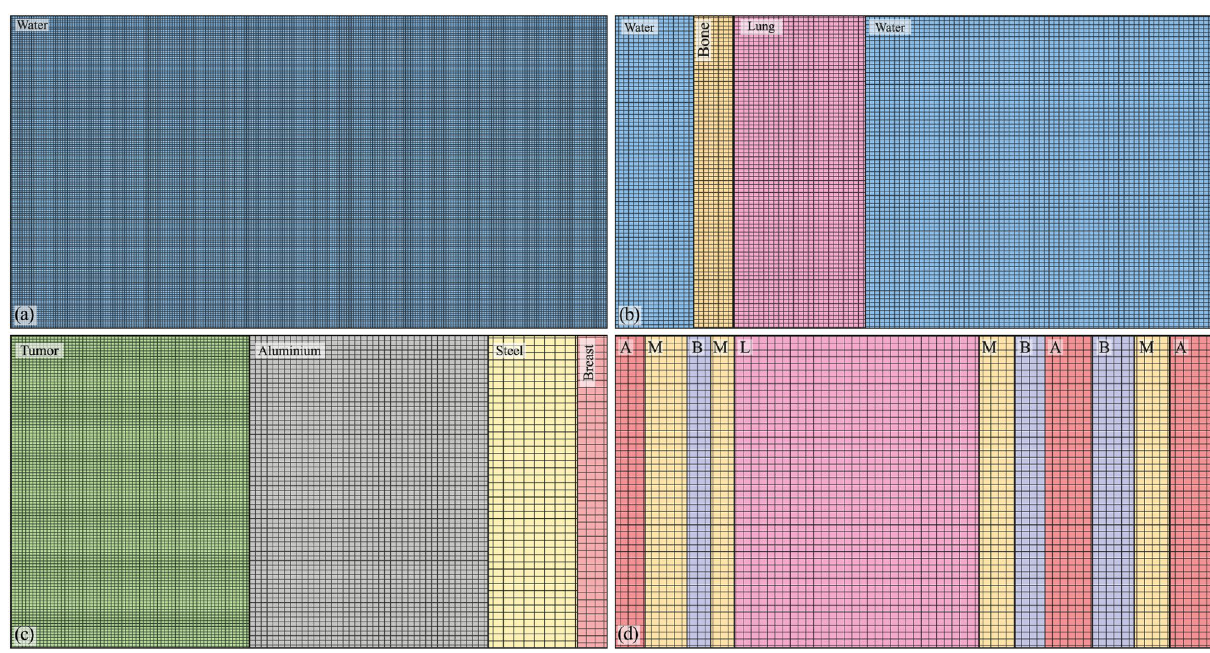
Figure 1. Benchmarks geometry: ( a ) water benchmark; ( b ) thorax benchmark; ( c ) intra-operative surgical benchmark and ( d ) high-heterogeneity benchmark. The material compositions are those of NIST. The electron source is monoenergetic and unidirectional. Lateral dimensions and source dimensions are fixed to the incident beam’s range. The percentage of materials’ thicknesses is then deduced from these dimensions. Longitudinal dimensions are